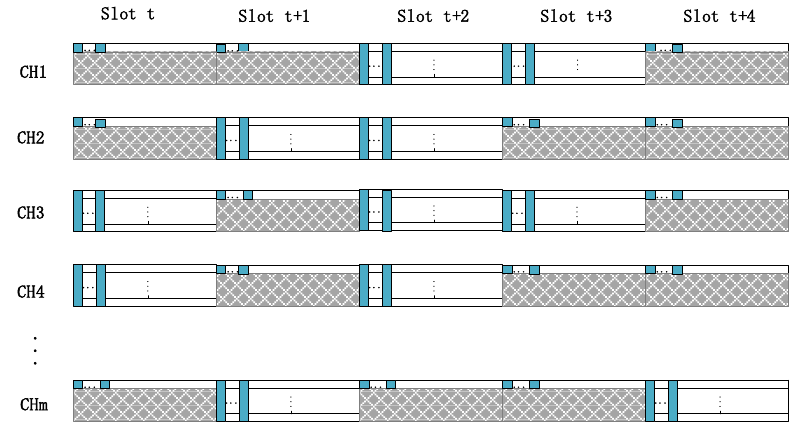
Figure 4. Distributed cooperative spectrum sensing. Algorithm 2 Distributed Channel Allocation Algorithm